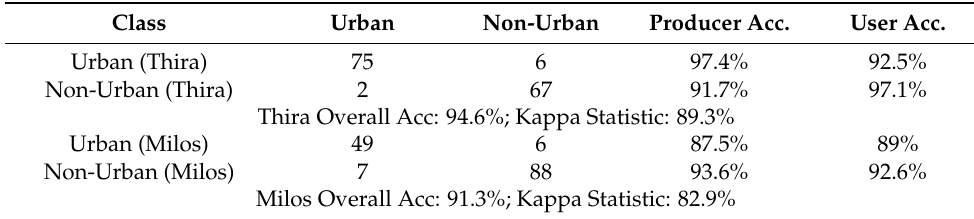
Table 3. Accuracy assessment table for the Thira and Milos classification map (2016). Class Urban Non-Urban Producer Acc. User Acc.